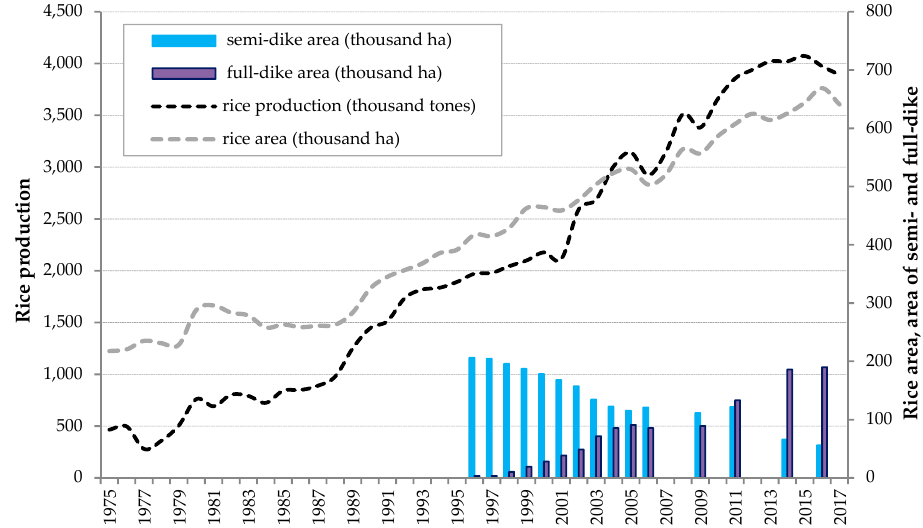
Figure 2. Rice area and production graph in multi-dike protection systems. Rice production was doubled from 2 million tons in 1997 to 4 million tons in 2017. Rice area and production data were collected from IRRI, spanning the 1975–2017 period; multi-dike area data were collected from Department of Agriculture and Rural Development (DARD) and Construction Department of An Giang during the period 1995–2016.